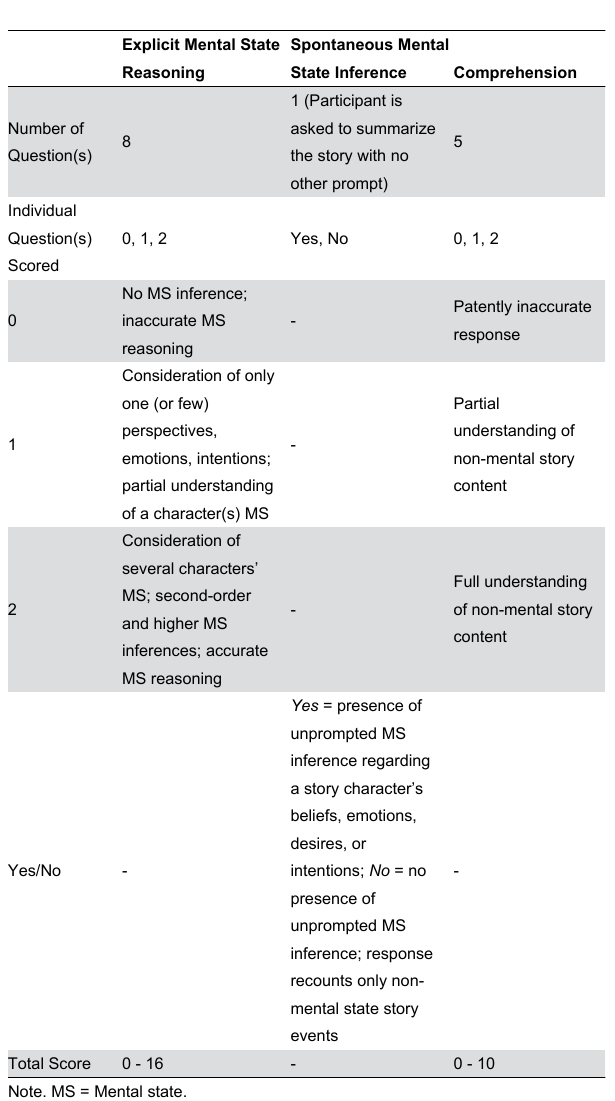
Table 1. Description of Assessment Questions and Scoring Criteria in the Short Story